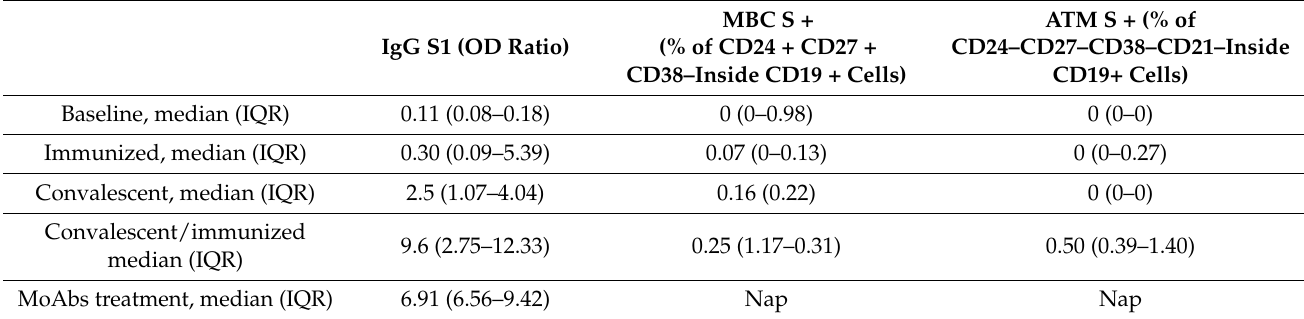
Table 3. SARS-CoV-2 anti-spike antibody immunoassay results and S1 memory B cells (MBCs) in CVID